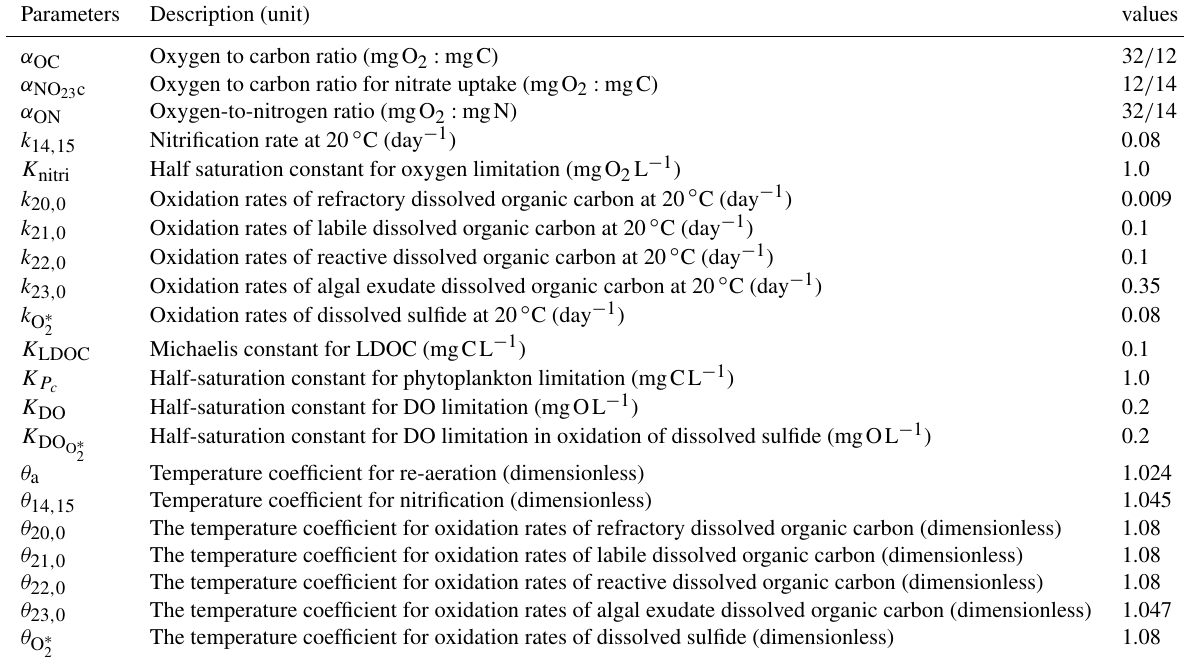
Table A2. Main parameters and constants for the water quality model (RCA).